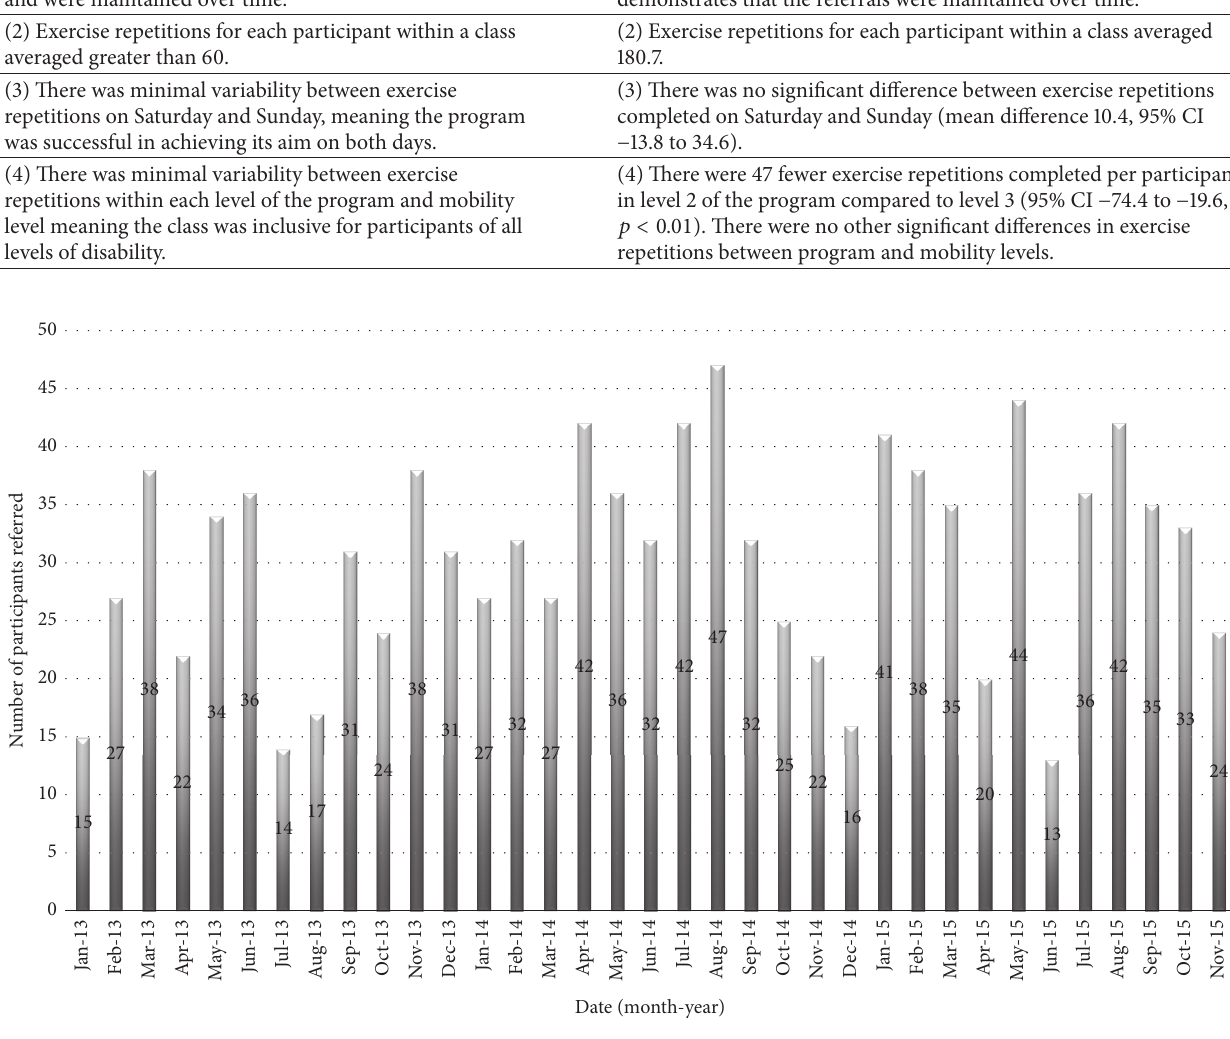
Figure 1: Number of participants referred to the program per